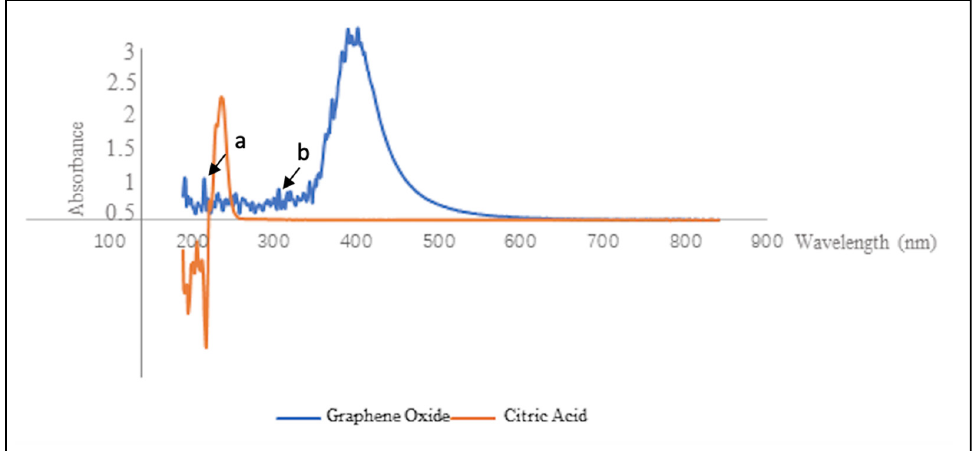
Figure 2. UV–visible adsorption spectrum of citric acid and GO. Arrow ( a ) represents π – π * transitions of aromatic C-C bonds. Arrow ( b ) represents n– π * transitions of C=O.